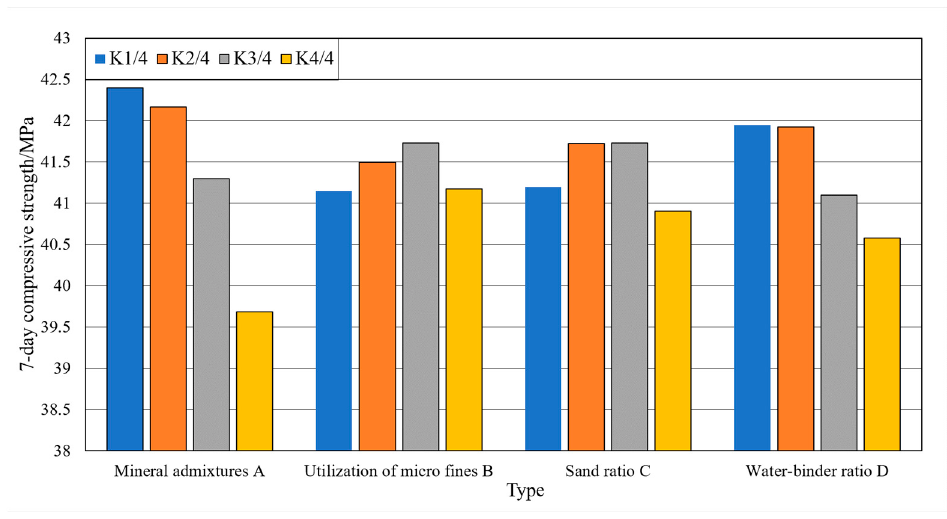
Figure 6. Trend of the influence of factors on the results of 7-day compressive strength test.